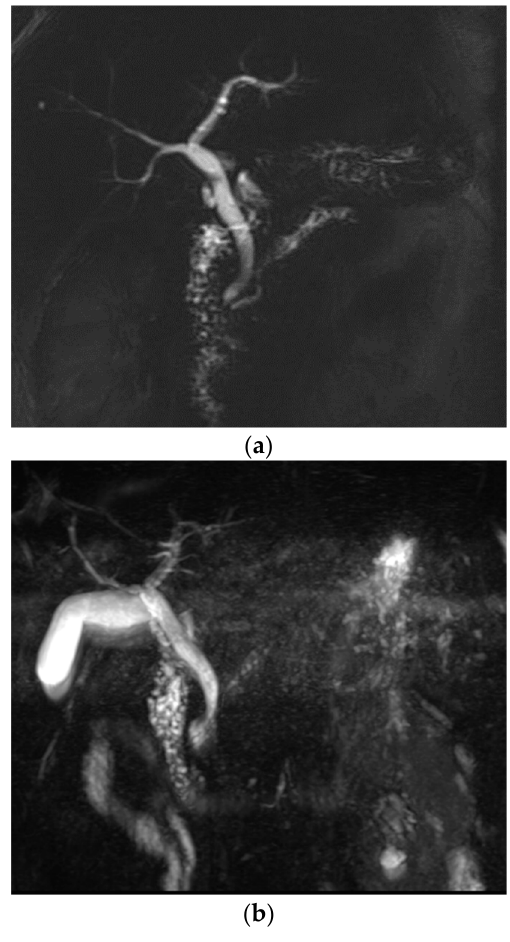
Figure 3. A 61-year-old male with a 5 mm sized distal CBD stone. A 2D thick-slab MRCP ( a ), as a reference standard, clearly depicts distal CBD stone (arrow) with upstream biliary dilatation. On conventional MRCP ( b ), the overall image quality is poor (score 1) mainly due to image degradation by severe artifacts (score 2), and the evaluation for the presence of distal CBD stone is limited. On optimized BH-CS-MRCP ( c ), overall image quality, image degradation by artifacts, and background suppression were excellent (score 5). In addition, visualization of distal CBD stone (arrow) as well as second branch IHD (solid arrowheads) and pancreatic duct (hollow arrowheads) is seen (score 5 for all of the pancreaticobiliary system).